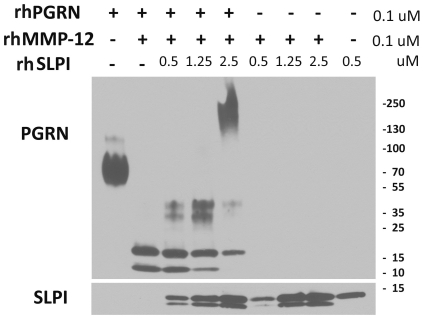
Inhibition of MMP-12-mediated PGRN cleavage by SLPI.Recombinant PGRN (0.1 µM) was incubated with activated MMP-12 (0.1 µM) with or without SLPI at indicated doses (0.5–2.5 µM) for 40 min at 37°C. Western blot was performed for PGRN and SLPI. Results show that MMP-12 mediated PGRN cleavage was dose-dependently inhibited by SLPI. Data are representative of three separate experiments with similar results.